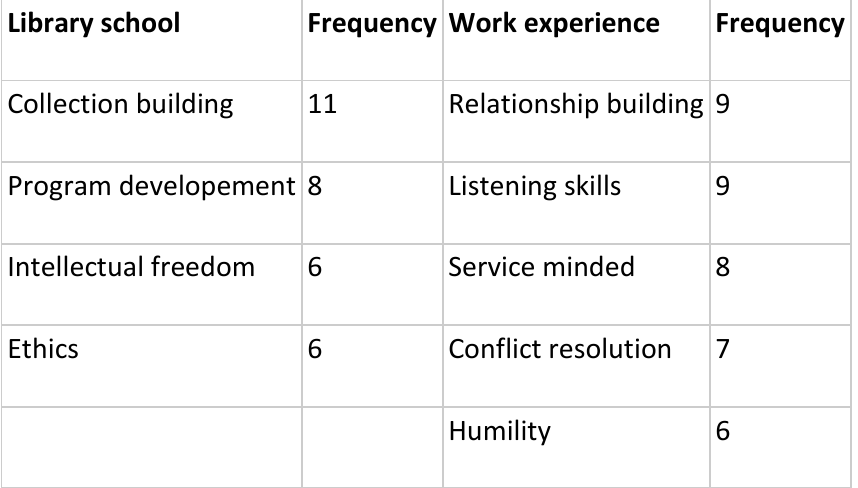
Table 1: Table of competencies that were mentioned or phrased similarly by at least six of the eleven